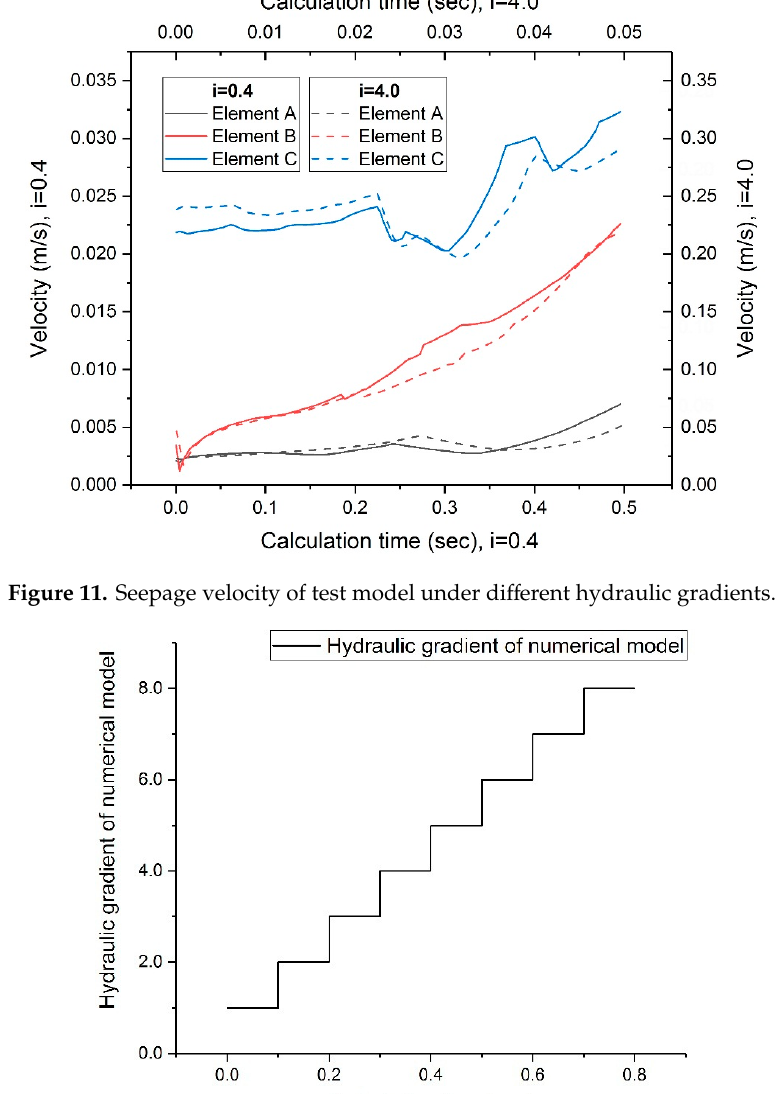
Figure 10. Porosity of the test model under different hydraulic gradients.